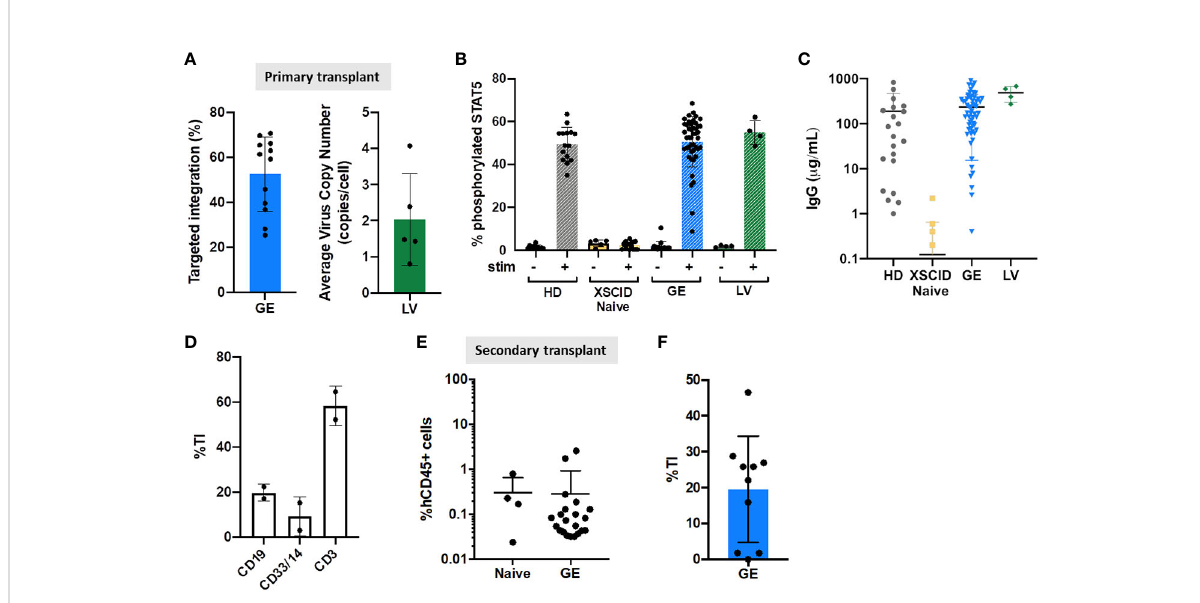
FIGURE 5 Genomic and functional correction in immunode fi cient mice transplanted with GE- and LV-treated XSCID HSPCs (A) Quanti fi cation of TI rates and VCN by ddPCR in the human CD45 + cells isolated from the bone marrow of transplanted mice at week 16-18 post-transplant. (B) Phosphorylation of STAT5 was measured in hCD45 + CD3 + T cells from the spleen by fl ow cytometry after 15 min stimulation with IL2/IL7 (+) or left unstimulated (-). (C) Human IgG production in immunode fi cient mice transplanted with HD, XSCID naïve and GE- or LV-treated HSPCs cells. Concentration of IgG was quanti fi ed by ELISA in the serum of transplanted mice at week 16-18 post-transplant. (D) Quanti fi cation of TI rates B-lymphoid (CD19 + ), T-lymphoid (CD3 + ) and myeloid (CD33 + /CD14 + ) cells after sorting from spleen of mice injected with GE XSCID HSPCs (n = 2). (E) Level of human CD45 + engraftment in mice bone marrow, at 16 weeks after secondary transplant with XSCID Naive (n = 4 mice) and GE-treated HSPCs (n = 21 mice) isolated from primary transplanted animals. (F) Quanti fi cation of TI rates in the human cells isolated from the bone marrow of secondary transplanted mice at week 16 post-transplant (n = 10 mice). Each symbol indicates a single